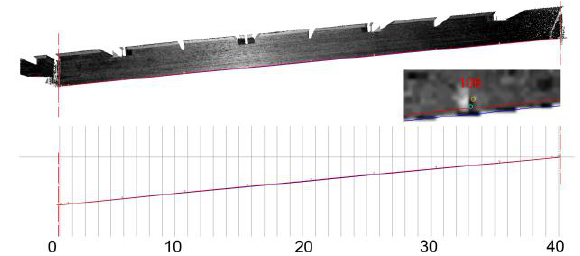
Figure 06. Graphical Processing: displacement profile